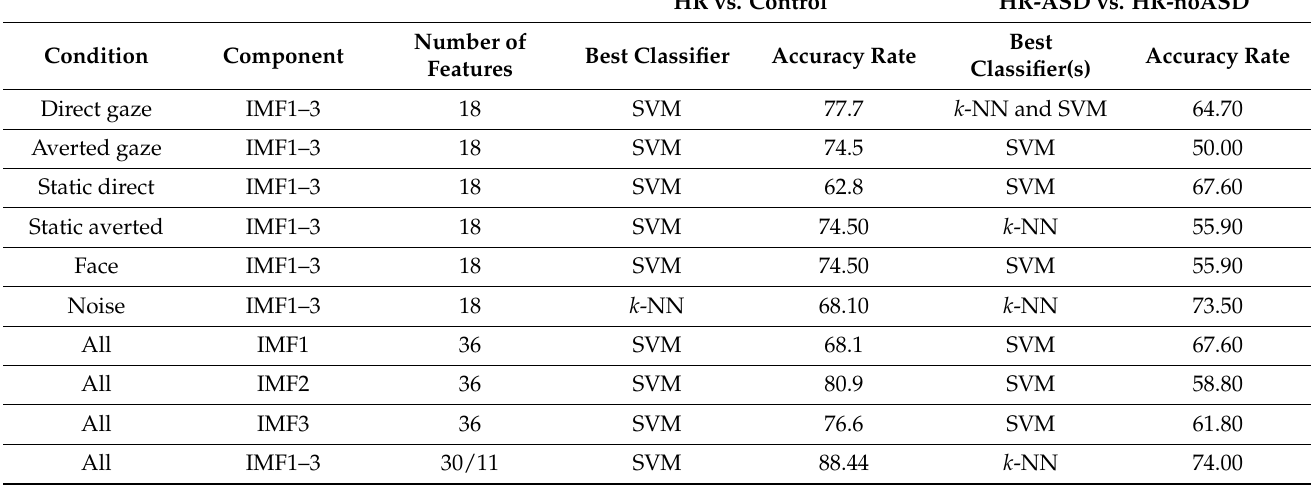
Table 4. Best results obtained for all experiments of this study for both HR vs. control and HR-ASD vs. HR-noASD classifications: the names of the best classifiers are presented along with their accuracy rate and the number of features used in each